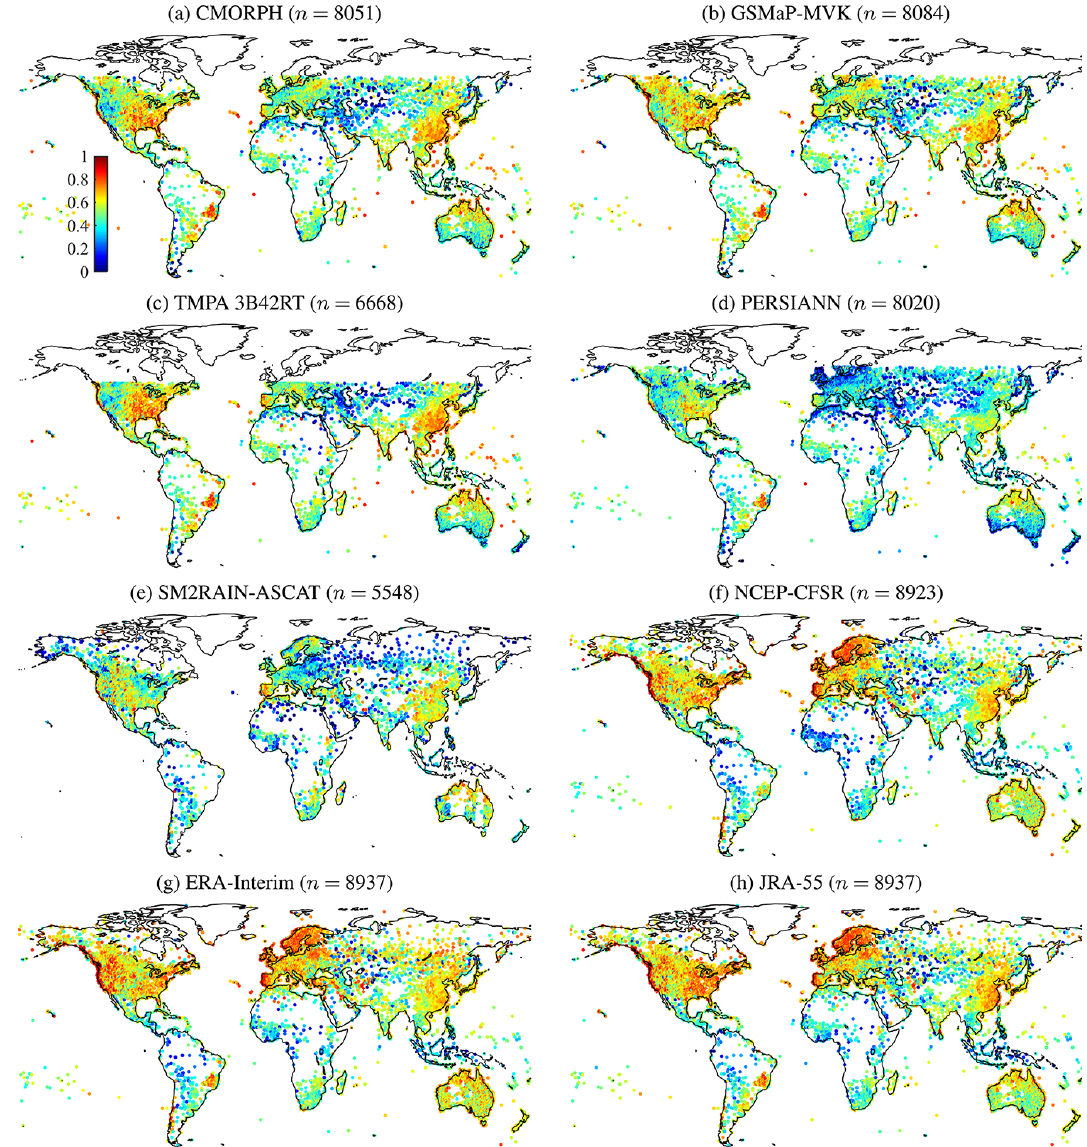
Figure 3. Correlation coefficients calculated between 3-day mean rainfall derived from the datasets and the gauges. Each data point represents a 0.5 ◦ grid cell containing at least one